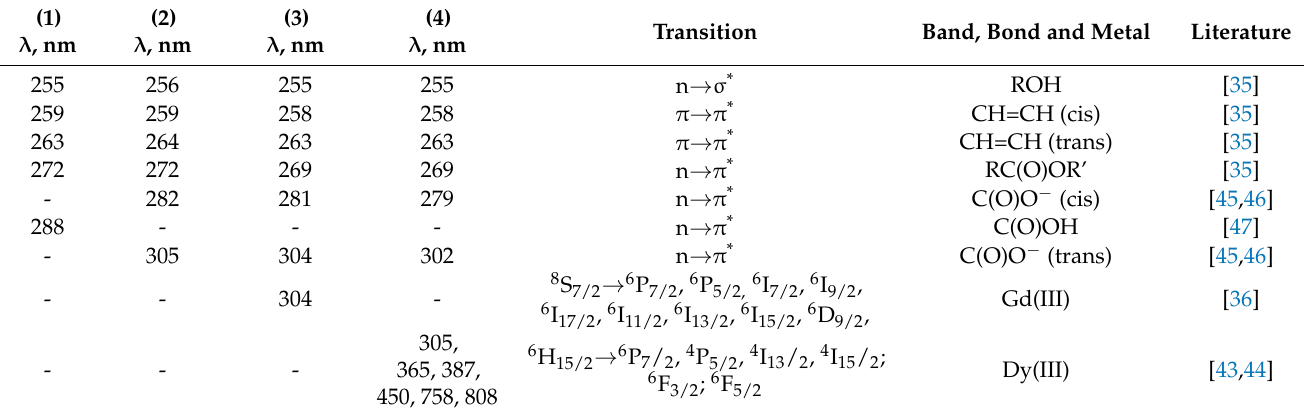
Table 1. Deconvolution of electronic spectra of compounds 1 , 2 and complexes Gd(III) 3, Dy(III) 4 in DMSO.